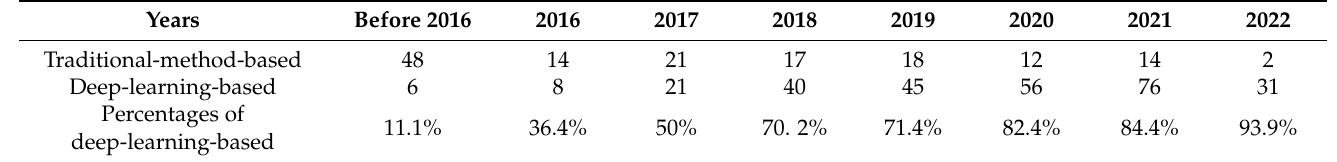
Table 1. The number of the traditional and deep-learning-based SAR ATR